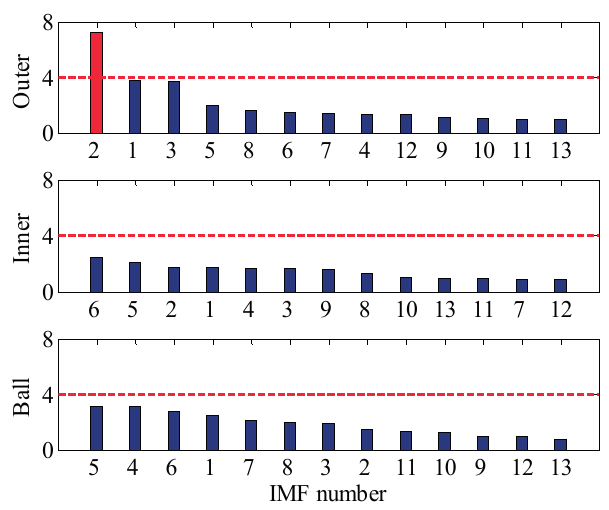
Figure 18. FSM of locomotive bearing signal.